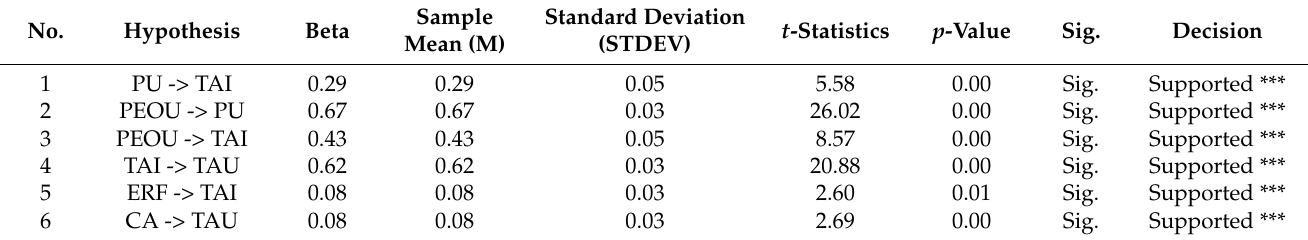
Table 4. The assessment of structural